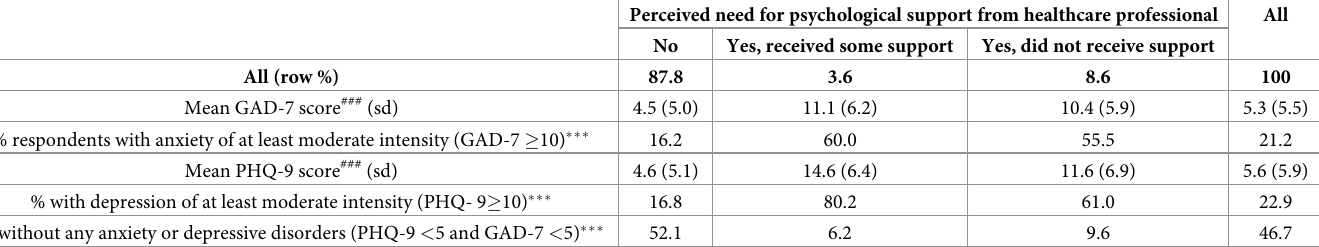
Table 1. Perceived need for psychological support from a healthcare professional in the general population in France and mental health indicators (COCONEL 2020, May 7–10, N = 2,003). Perceived need for psychological support from healthcare professional